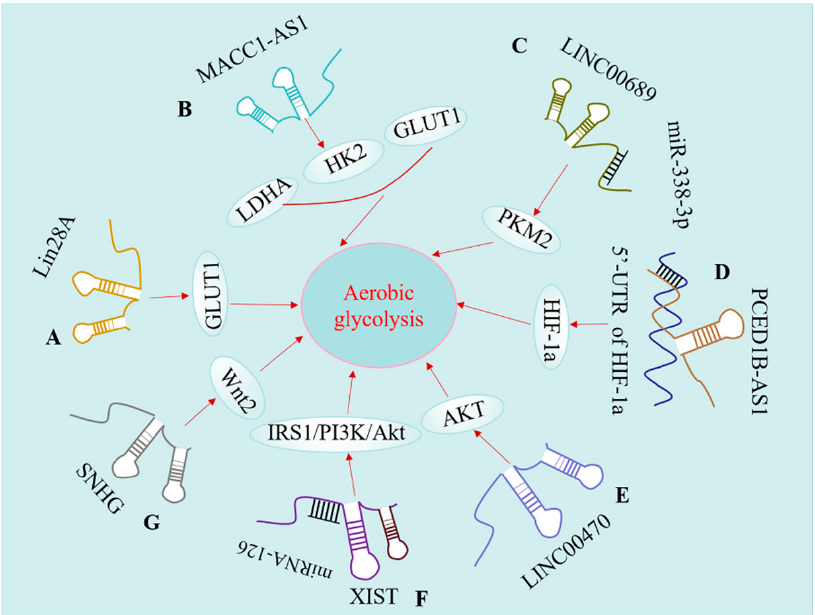
Figure 4. LncRNAs modulate the aerobic glycolysis of glioma. ( A ) Lin28 can enhance the expression of GLUT1; ( B ) MACC1-AS1 can promote the expression of LDHA, HK2, and GLUT1; ( C ) LINC00689 can increase PKM2 expression by binding to miR-338-3p; ( D ) PCED1B activates HIF-1a by binding to 5 ′ -UTR of HIF-1a mRNA; ( E ) LINC00470 activates the AKT pathway to promote aerobic glycolysis of glioma; ( F ) XIST regulates the glucose metabolism via targeting the IRS1/PI3K/Akt pathway in glioma. ( G ) SNHG can promote cell growth and aerobic glycolysis by upregulating Wnt2 in GBM.